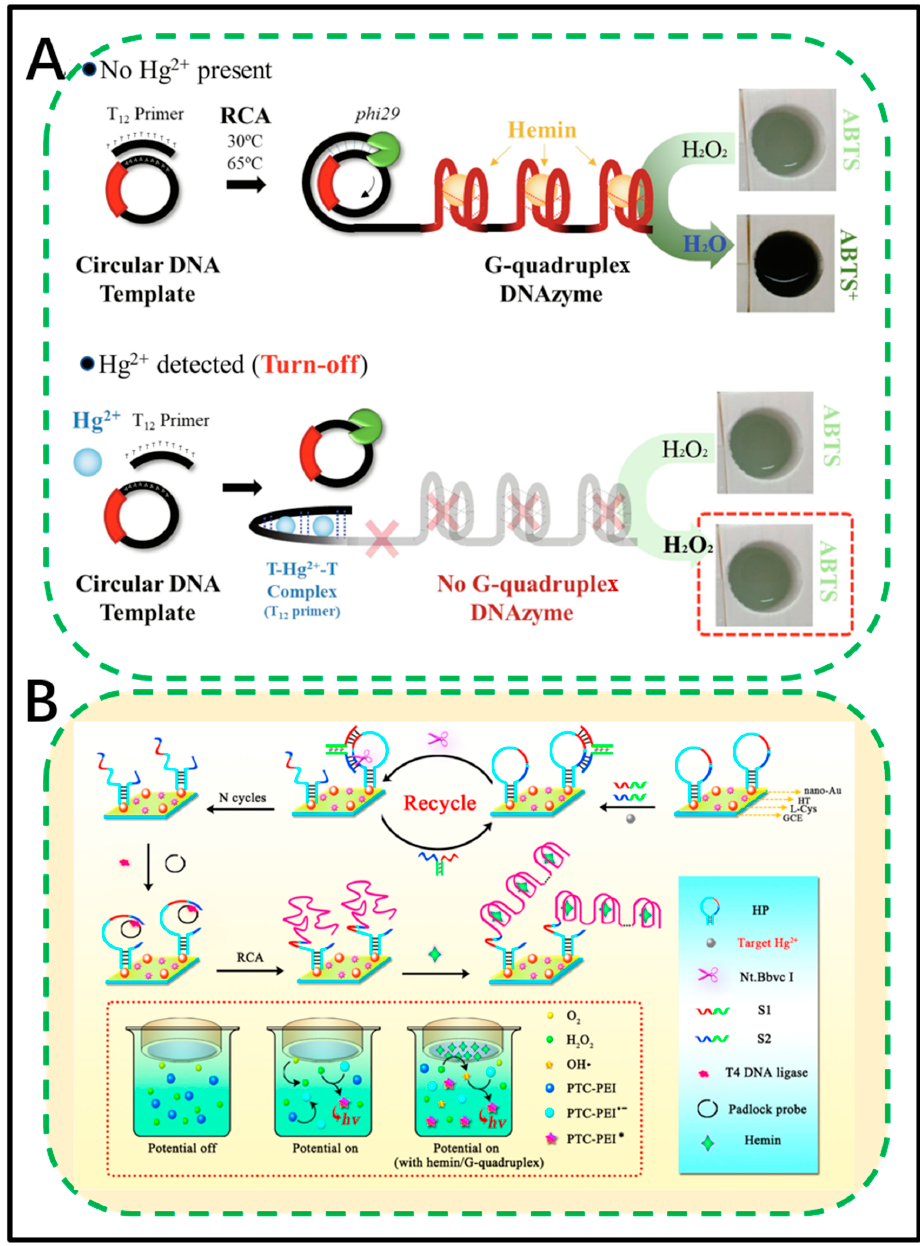
Figure 2. RCA assay for Hg detection. Adapted with permission from ref. [27,79]. ( A ) Colorimetric change of the detection chip when there are no mercury ions in the sample and when mercury ions are present. ( B ) Signal opening sensor based on novel covalently crosslinked perylene derivative (PTC-PEI) system design.